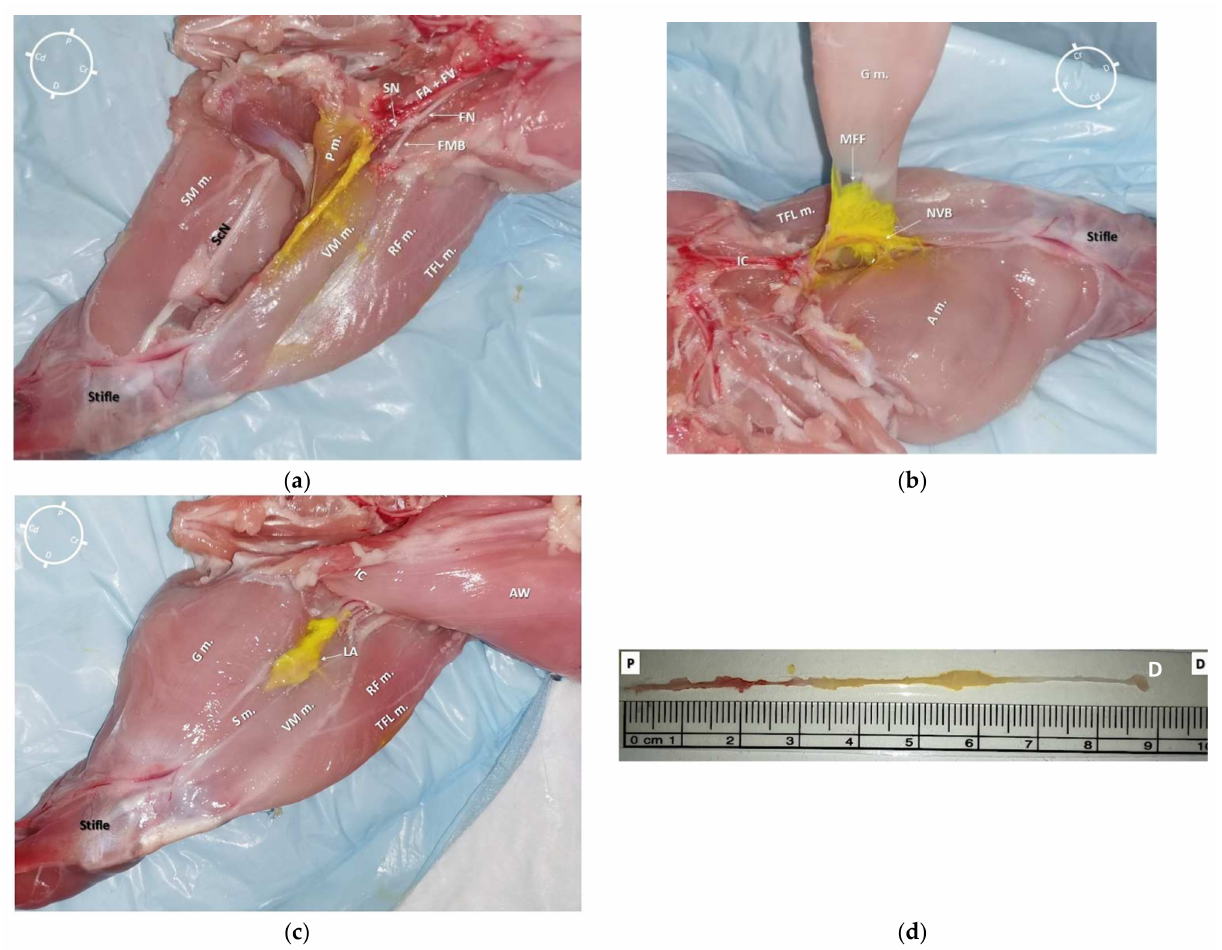
Figure 7. ( a ) Medial view of a left hind-limb of a rabbit cadaver in which a high volume of dye solution (0.1 mL/kg, of permanent yellow tissue dye solution and lidocaine 2% (1:50) was injected)). It was possible to observe the underlying tissues stained by the dye solution in the central portion of the medial aspect of the thigh. ( b ) Medial view of the same hind-limb after partial dissection of the gracilis muscle. It was possible to observe the distribution of the dye solution inside the medial femoral fascia (MFF), which contained the saphenous nerve (SN) and both the femoral artery (FA) and vein (FV). ( c ) Anatomical dissection of the medial aspect of the same hind-limb. The gracilis, sartorius, and adductor magnus muscles were bluntly removed. It was possible to observe the staining along the neurovascular structures (SN, FA, and FV) without staining both the femoral nerve (FN) and its motor nerve branches (the tissue dye stain on the vastus medialis and pectineus muscles resulted after opening of the medial femoral fascia during the dissection). It was possible to localize the pectineus muscle insertion onto the surface of the femur at the level of the first third of the thigh, which was caudal and lateral in relation to the SN. ( d ) The SN was completely removed from the cadaver (from where it branched off the FN to the proximal stifle, where it deepened to innervate the articular capsule) for the evaluation of its total length (8.7 cm) and extent of staining from the tissue dye solution (4.2 cm). S m.: sartorius muscle; VM m.: vastus medialis muscle; G m.: gracilis muscle; TFL m.: tensor fascia latae muscle; RF m.: rectus femoris muscle; P m.: pectineus muscle; IC: Inguinal crease; NVB: neurovascular bundle; AW: Abdominal wall; LA: local anesthetic and tissue dye solution; FMB: femoral motor branches; ScN: Sciatic nerve; SM m.: Semimembranosus muscle; A m.: adductor magnus muscle; P: Proximal; D: Distal; Cr: Cranial; Cd: Caudal. Individual total SN length, SN length of stain, and percentage of the total length of the nerve stained, reported as mean and standard deviation, are described in Table